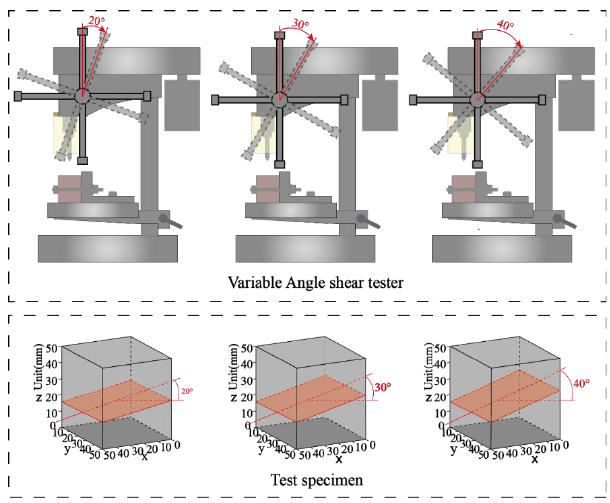
Figure 4. Schematic diagram of sample rock samples with different dip angles.